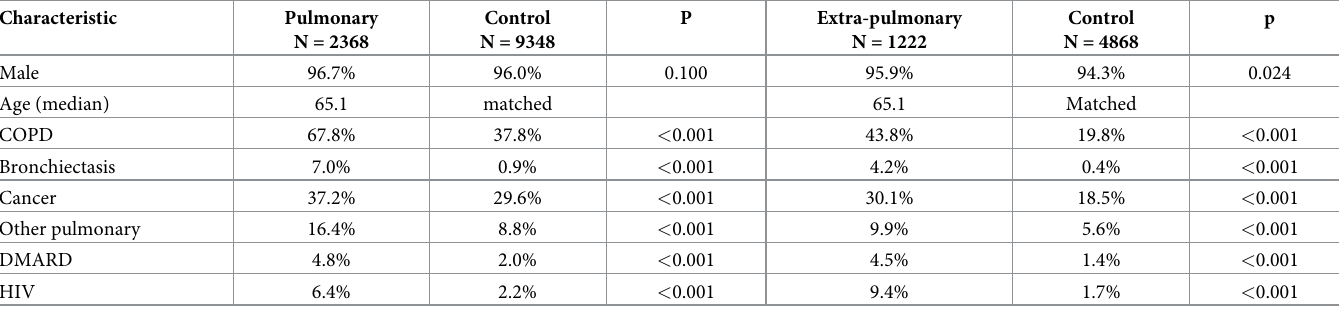
Table 2. NTM patient demographics and major co-morbidities, along with age- and setting-matched controls. Characteristic